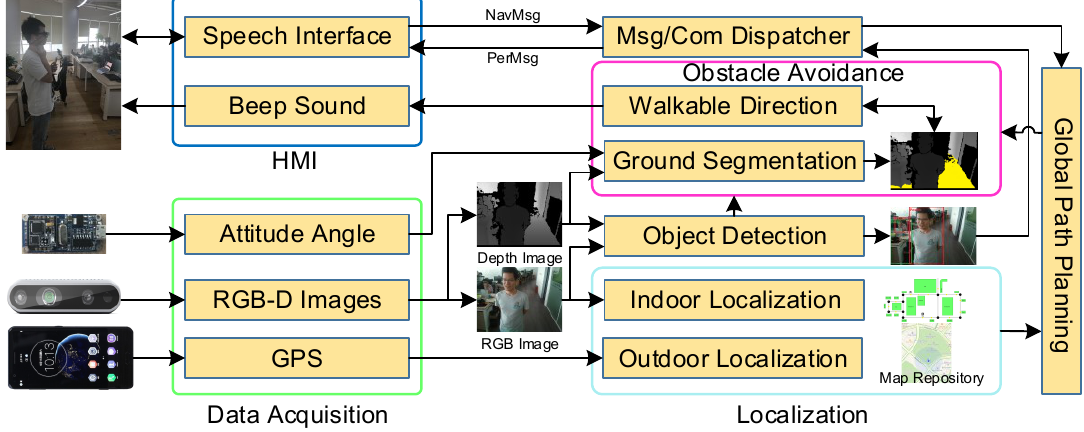
Figure 2. System overview: PerMsg-perception message, NavMsg-navigation